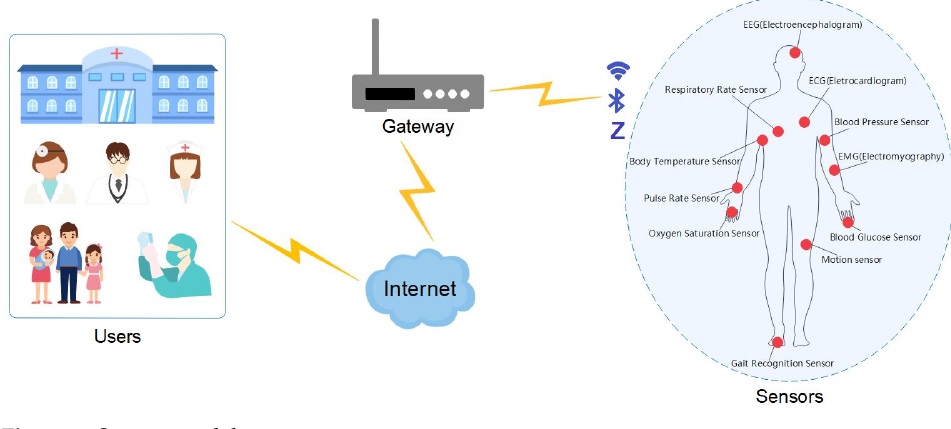
Figure 1. System